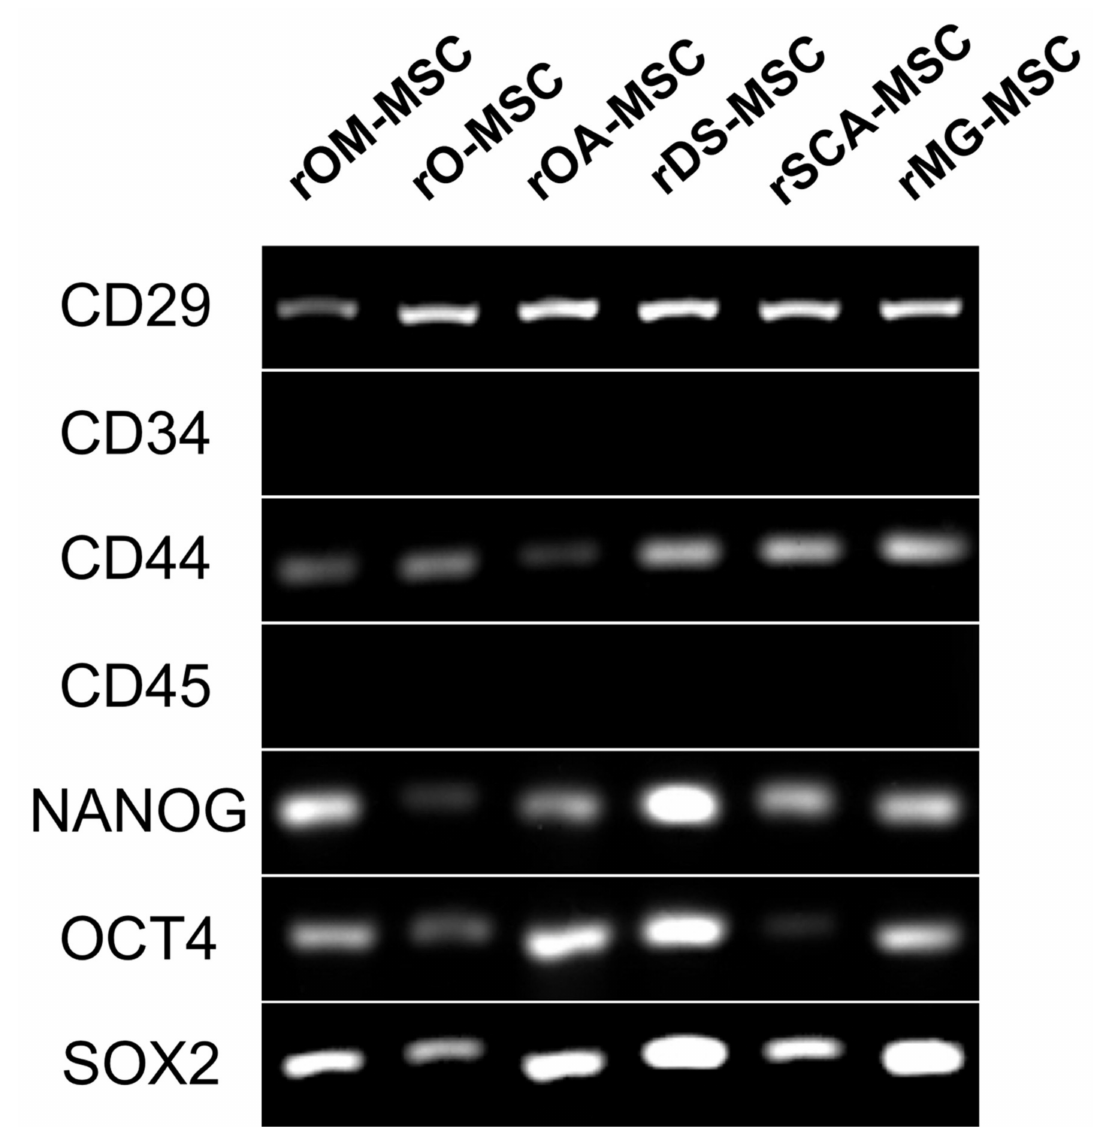
Figure 3. RT-PCR analysis of surface and pluripotency marker gene expression in the different rMSC. A panel of surface markers including CD29, CD34, CD44, and CD45 was used for the identification of rMSC. Pluripotency genes expression (NANOG, OCT4, and SOX2) was detected in the different